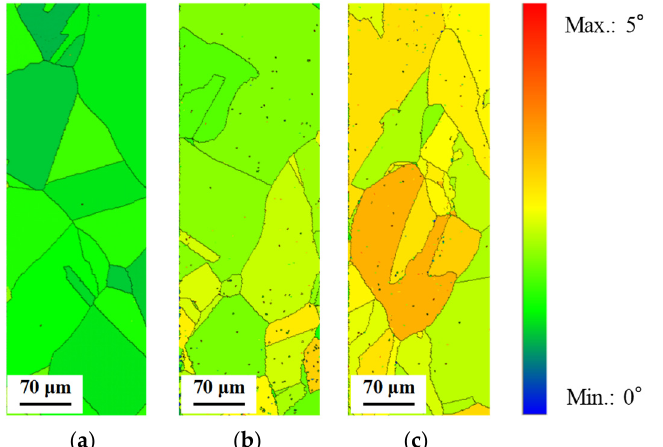
Figure 8. IPF maps of heat-treated C1020 specimens after low cycle fatigue test. ( a ) Stress amplitude: 50 MPa (fatigue cycle: 7,786,201 cycles); ( b ) stress amplitude: 75 MPa (fatigue cycle: 235,144 cycles); ( c ) stress amplitude: 100 MPa (fatigue cycle: 49,676 cycles).